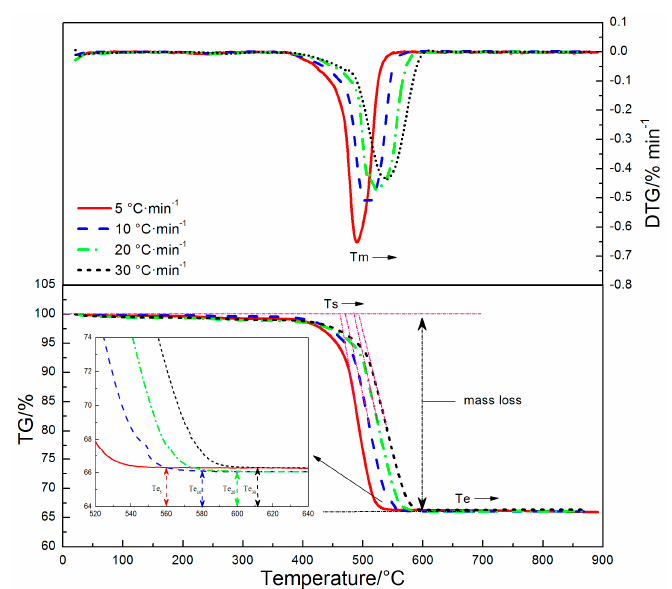
Figure 3. TG/DTG profiles of the siderite sample at different heating rates.